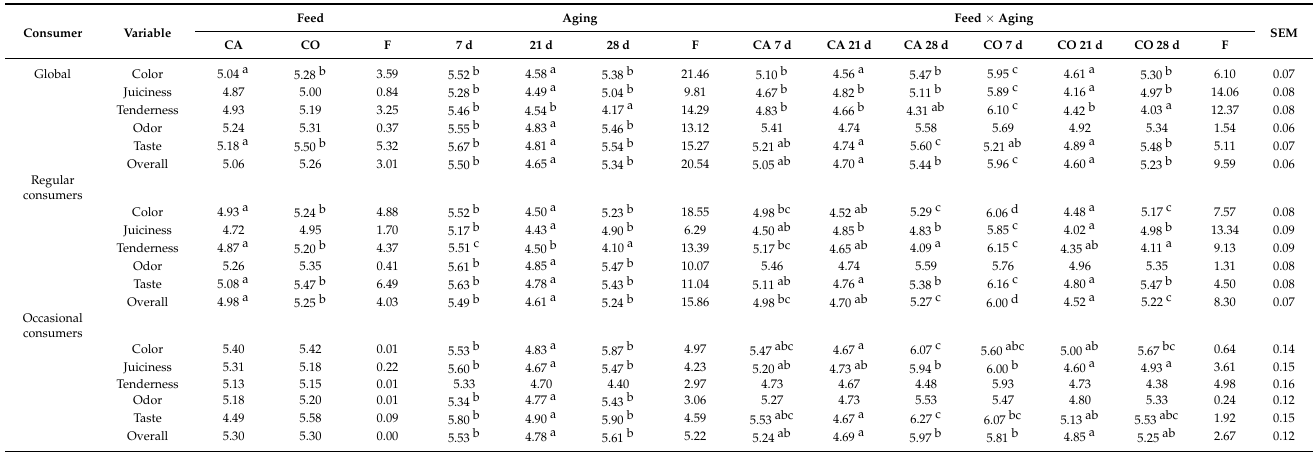
Table 2. Sensory assessment of beef with different feeds and aging for all consumers, regular consumers, and occasional consumers of beef.